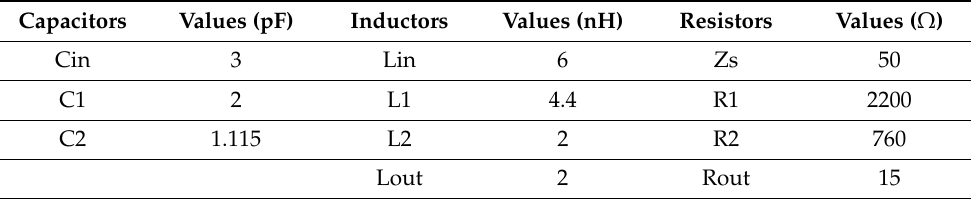
Figure 7. ( a ) Equivalent circuit model and ( b ) reflection coefficient of the equivalent circuit model. Table 2. Values of the components used in the circuit model.